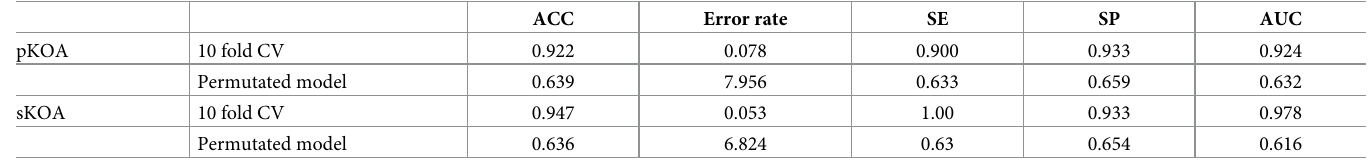
Table 4. Comparison of the performance of the 10 CV (10 fold cross validation) model and the permutated